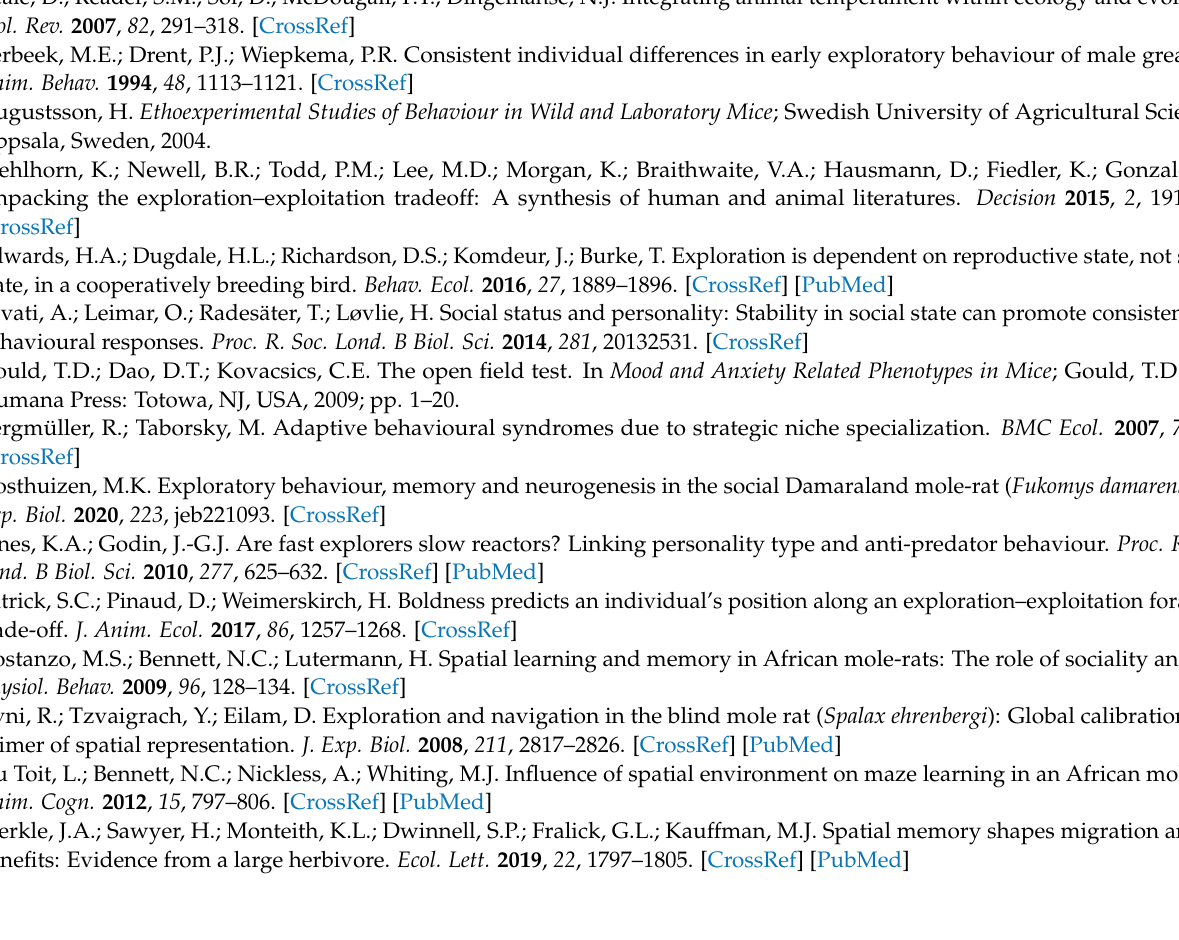
mole-rats in an open-field box. Individual data points for each tested animal are represented by dots. Figure S2: Total tunnel entries ( ± SE) (A) and total number of tunnels visited ( ± SE) (B) by colony- and single-housed Damaraland mole-rats in an open-field box. Significant differences between pairs are indicated by letters above the bars ( p < 0.05). Individual data points for each tested animal are represented by